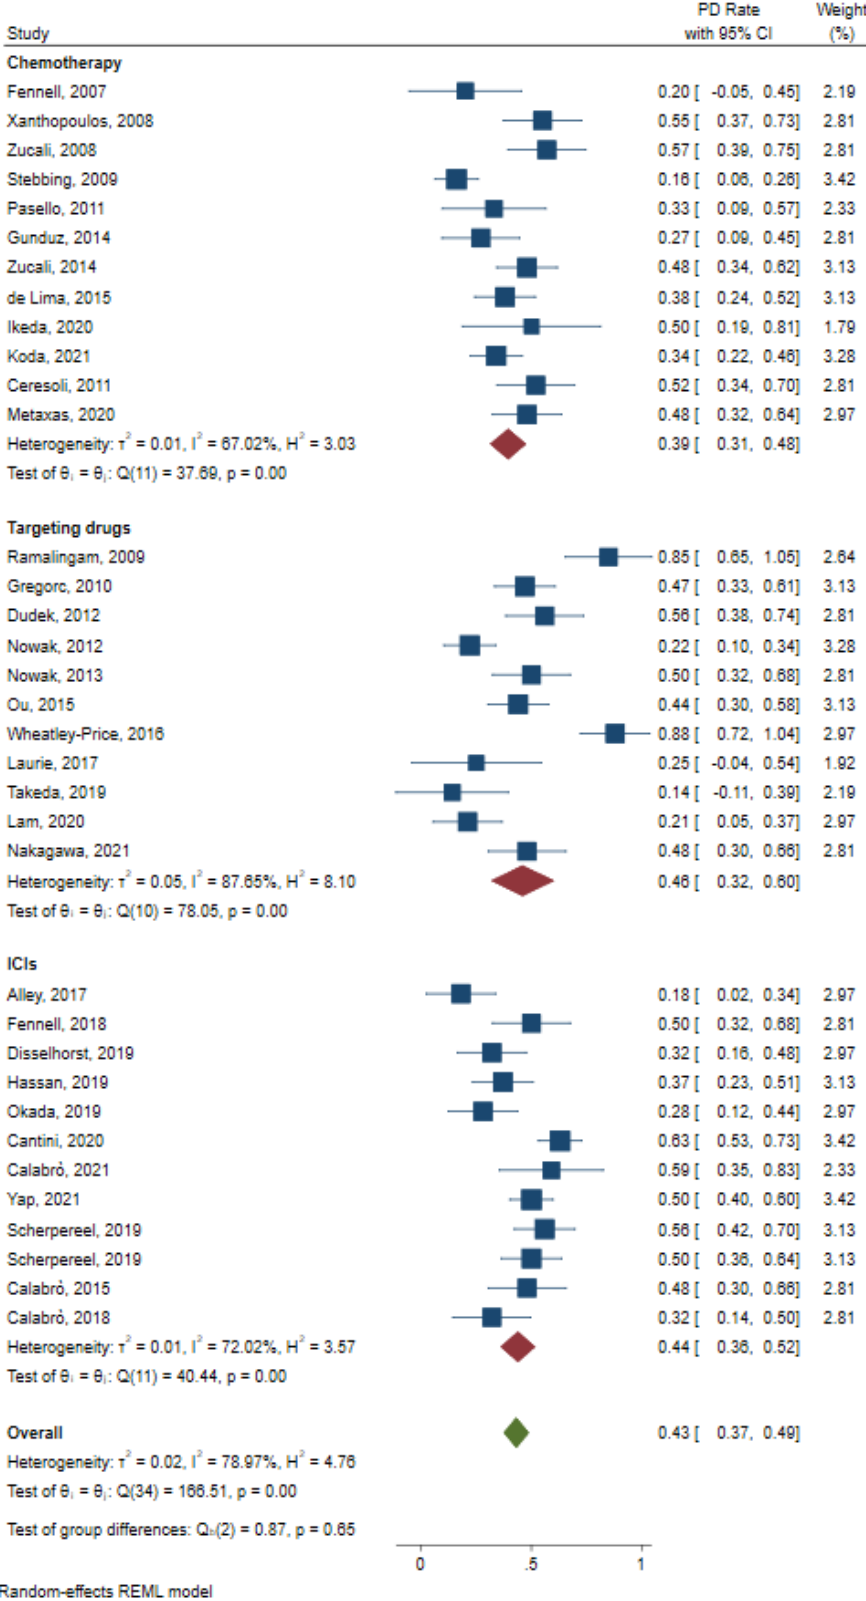
Figure 7. Pooled analysis of PD rate for chemotherapy, ICIs, and targeting drugs. PD: progression disease [7,9 – 13,15 – 19,21 – 25,27 – 32,34 – 41,43,46,47,49] . disease